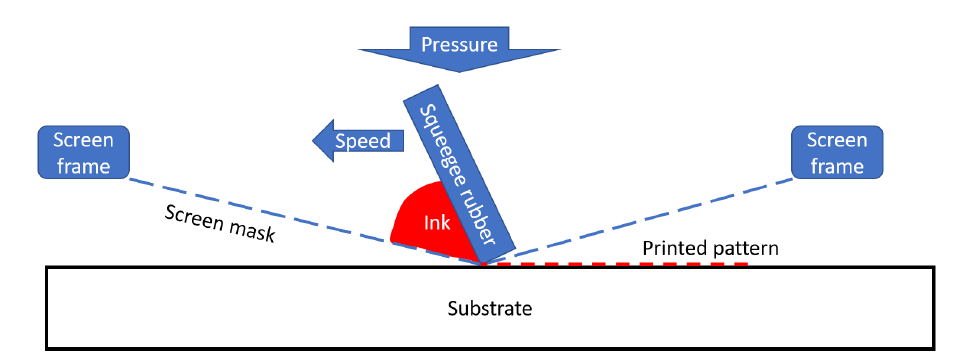
Figure 15. Schematics of screen